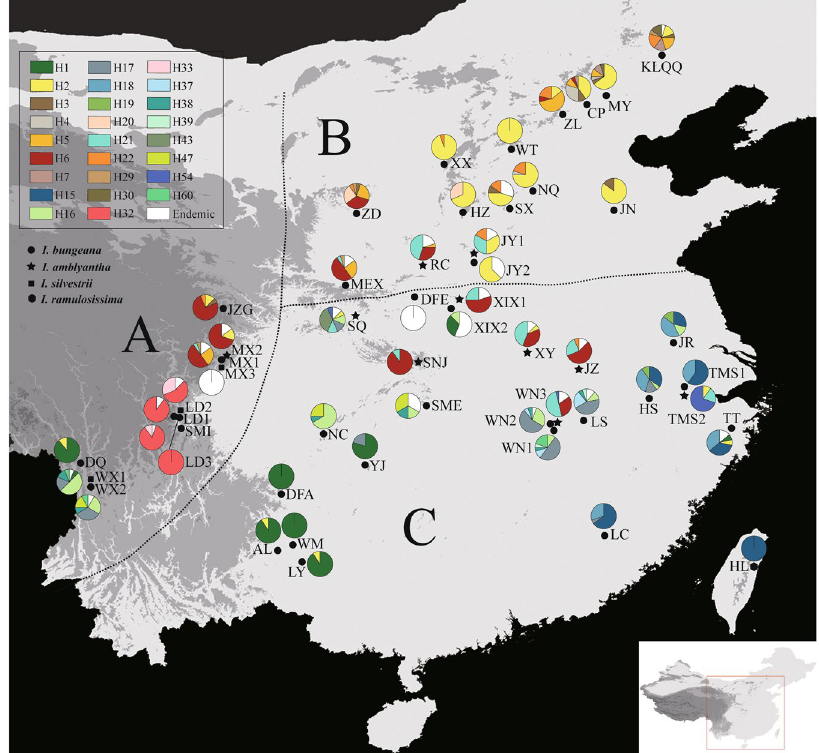
Figure 3. Geographic distribution of Pgk1 haplotypes detected in Indigofera bungeana complex. The haplotypes found in more than one population are color-coded, while private haplotype particular to each population are shown in white. Figure was generated in DIVA-GIS 7.5